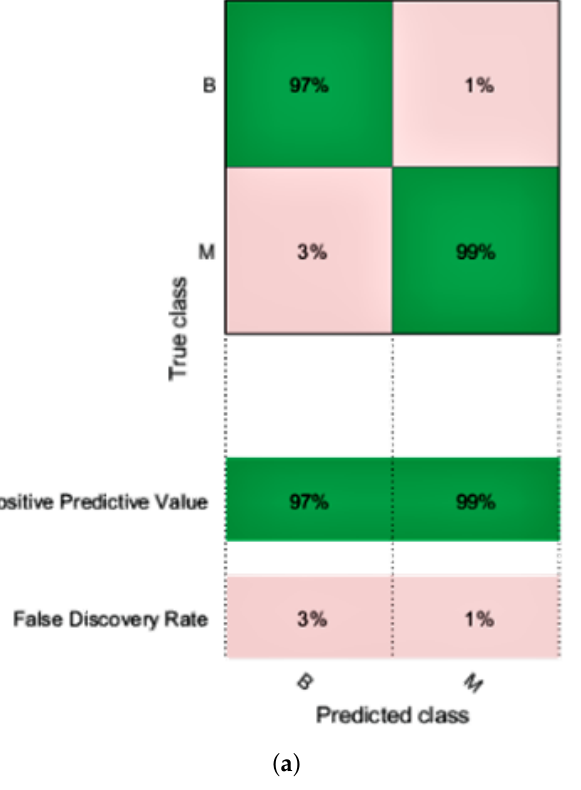
Figure 5. Results of Support Vector Machine. ( a ) Confusion Matrix; ( b ) AUC of SVM.